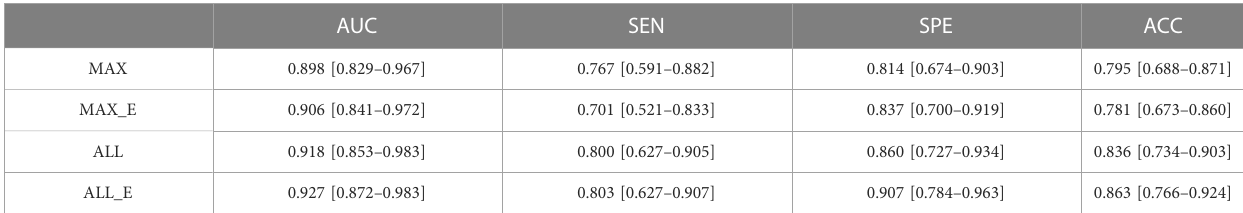
TABLE 2 ROC analysis of four ROI methods for the external validation set.